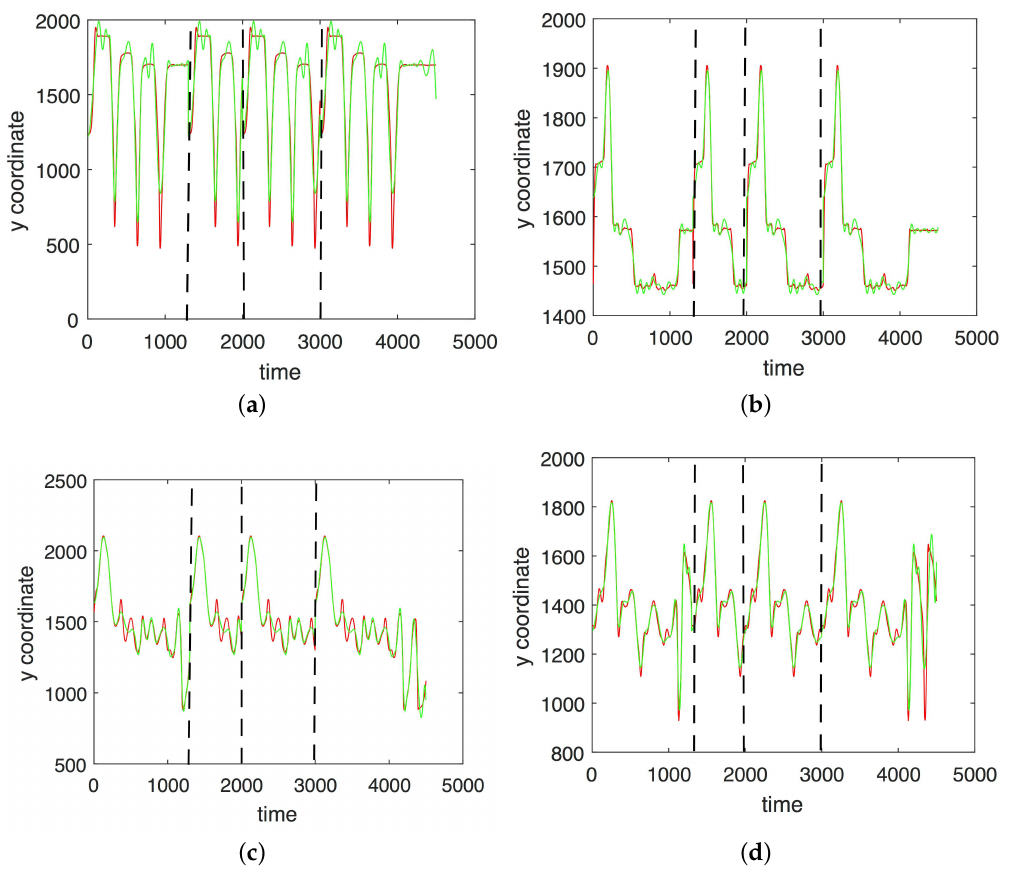
Figure 4. An approximation of y -coordinates by 25 satellites and two centers of motion (CMU 86 Trial 1; sampled at 120Hz). ( a ) Right heel; ( b ) Left heel; ( c ) Right wrist, distal; ( d ) Left wrist, distal. The red curve shows the experimentally observed coordinates and the green curve gives their neural